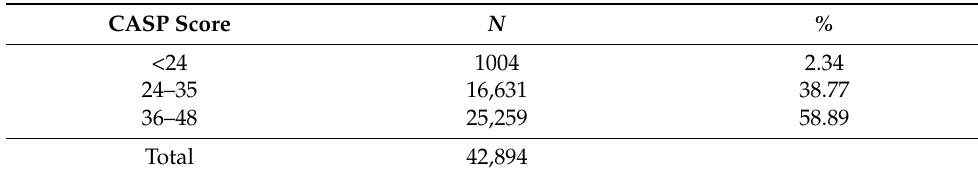
Table A3. Frequency and percentage of the score for CASP score–index for quality of life and well-being.